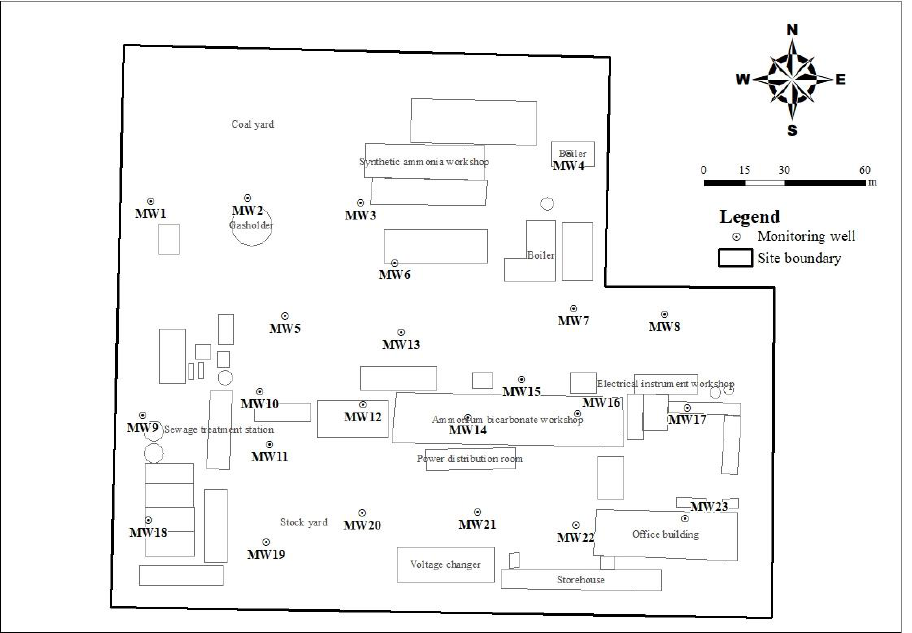
Figure 1. Layout plan of the nitrogenous fertilizer plant area and the sampling sites. “MW” indicates the monitoring well. The squares indicate the plant buildings. The circles indicate the other ’ s structures, such as the gas tank and factory chimneys.